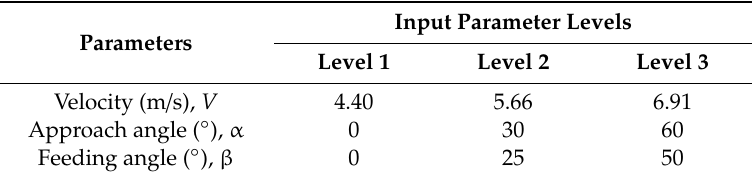
Table 1. Experimental parameters and their levels Input Parameter Levels Parameters Level